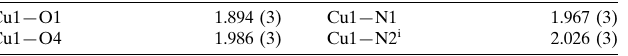
Bruker APEXII diffractometer Absorption correction: multi-scan ( SADABS ; Sheldrick, 1996) T min = 0.335, T max = 0.542